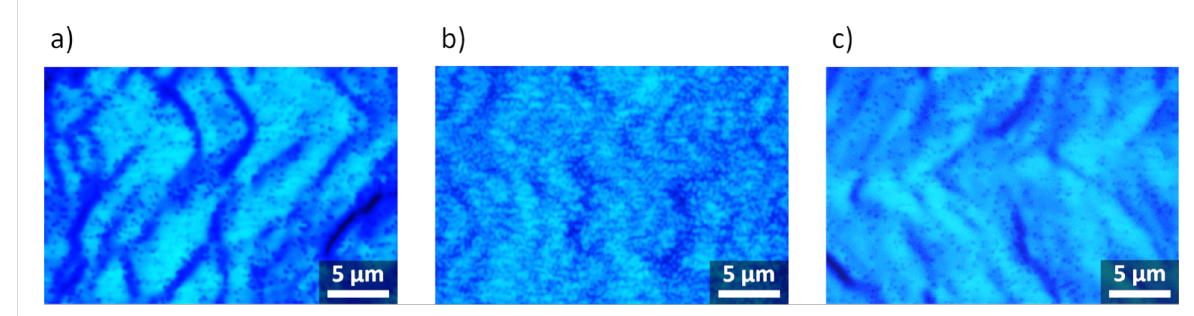
Figure 3: PL images of A (a), D (b) and E (c) used for determination of dislocation density.